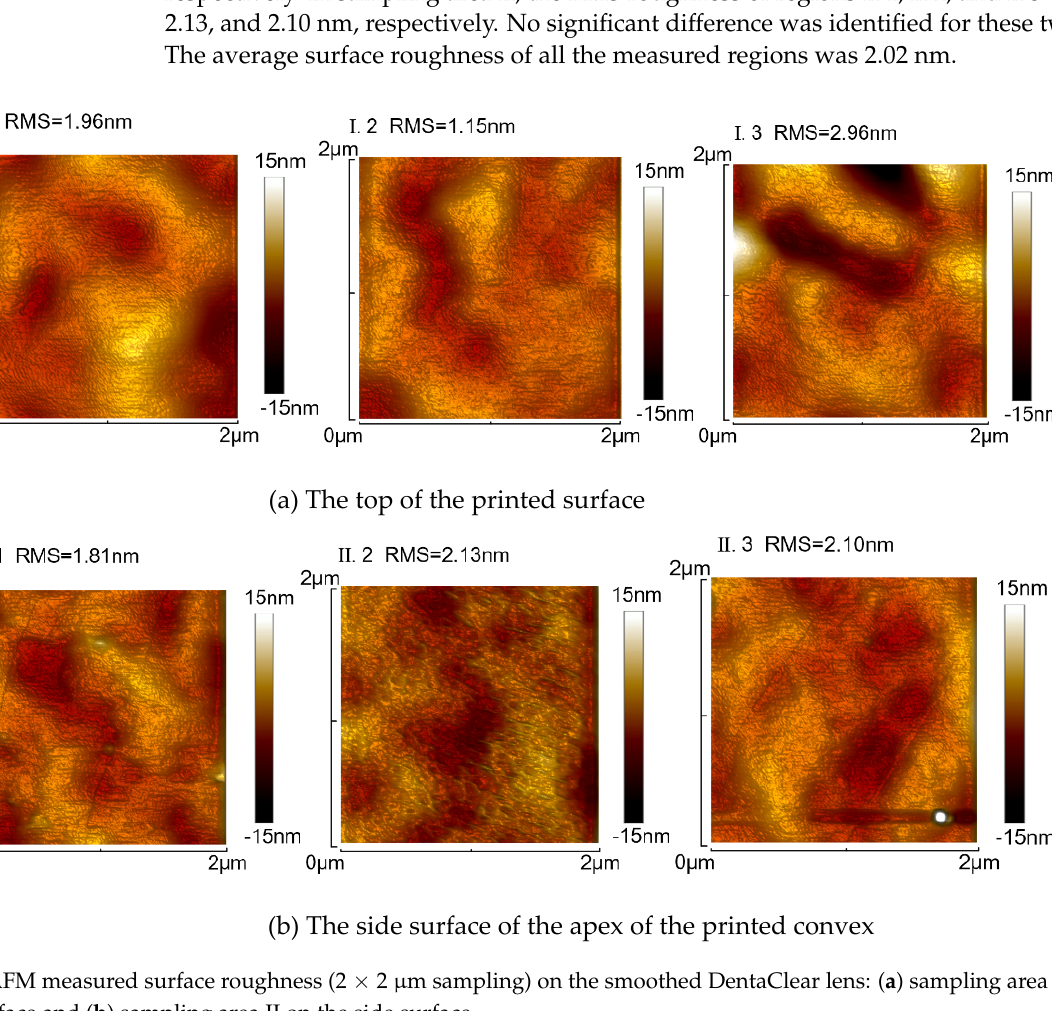
Measured length/mm HEMA lens after smoothing i Figure 8. ( a ) Schematic diagram of sampling curves on lens surfaces in the profilometer measure- ments: each curve has a length of 15.2 mm. ( b ) Printed surface profile and ( c ) deviation of Denta- Clear lenses compared to the designed profile. ( d ) Printed surface profile and ( e ) deviation of HEMA lenses compared to the designed profile. ( f ) Surface roughness of printed DentaClear lens without smoothing. ( g ) Surface roughness of printed DentaClear lens after smoothing. ( h ) Surface roughness of printed HEMA lens without smoothing. ( i ) Surface roughness of printed HEMA lens after smoothing. Table 1. Surface properties of the lenses without and after smoothing.